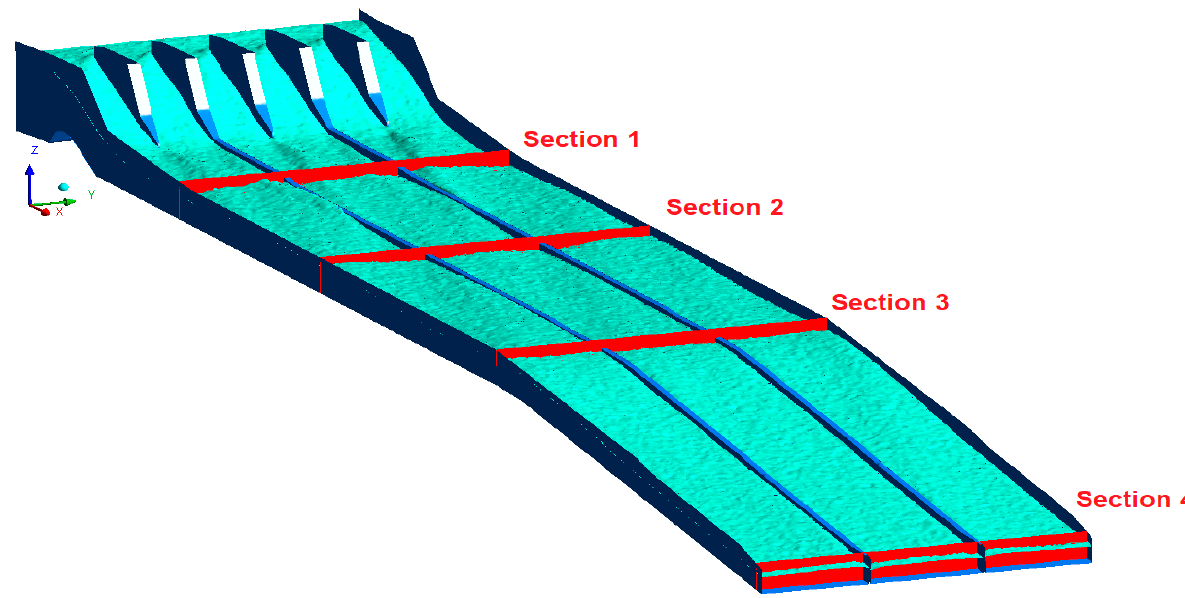
Figure 13. CFD analysis water surface overview and measurement cross-sections.